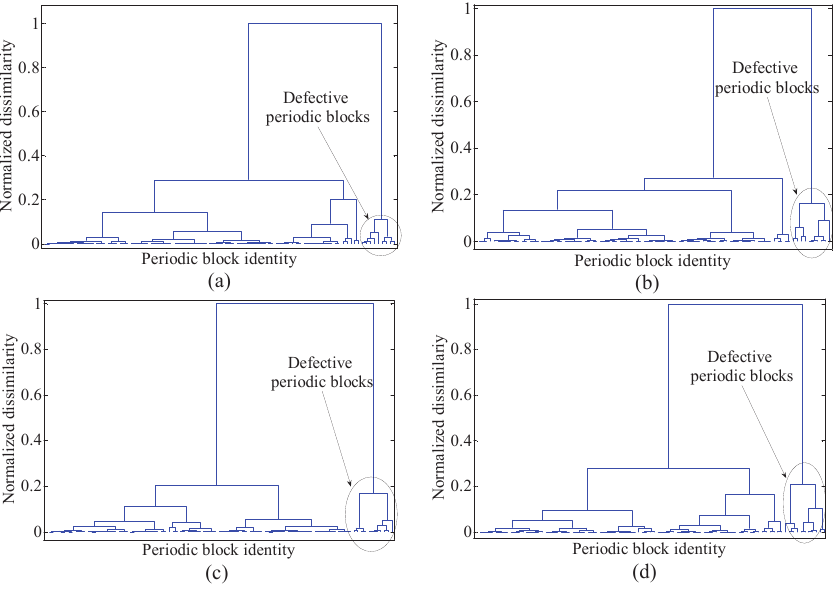
Figure 11. Dendrogram resulting from cluster analysis of specific variances obtained from the quality index matrix for the image cropped from (a) top-left (b) bottom-left (c) top-right and (d) bottom-right corners. Defective blocks identified from these cropped images are (23, 64, 63, 44, 34, 33, 43, 53, and 54), (23, 73, 34, 44, 33, 53, 63, 44, 64, and 54), (13, 34, 24, 64, 23, 43, 44, 54, 33, 53, and 63) and (13, 24, 34, 64, 23, 63, 33, 53, 43, 44, and 54). It may be noted that since the cropped images have more number of periodic blocks, the identities of the periodic blocks in the abscissa are not shown in order to avoid crowd and to have better